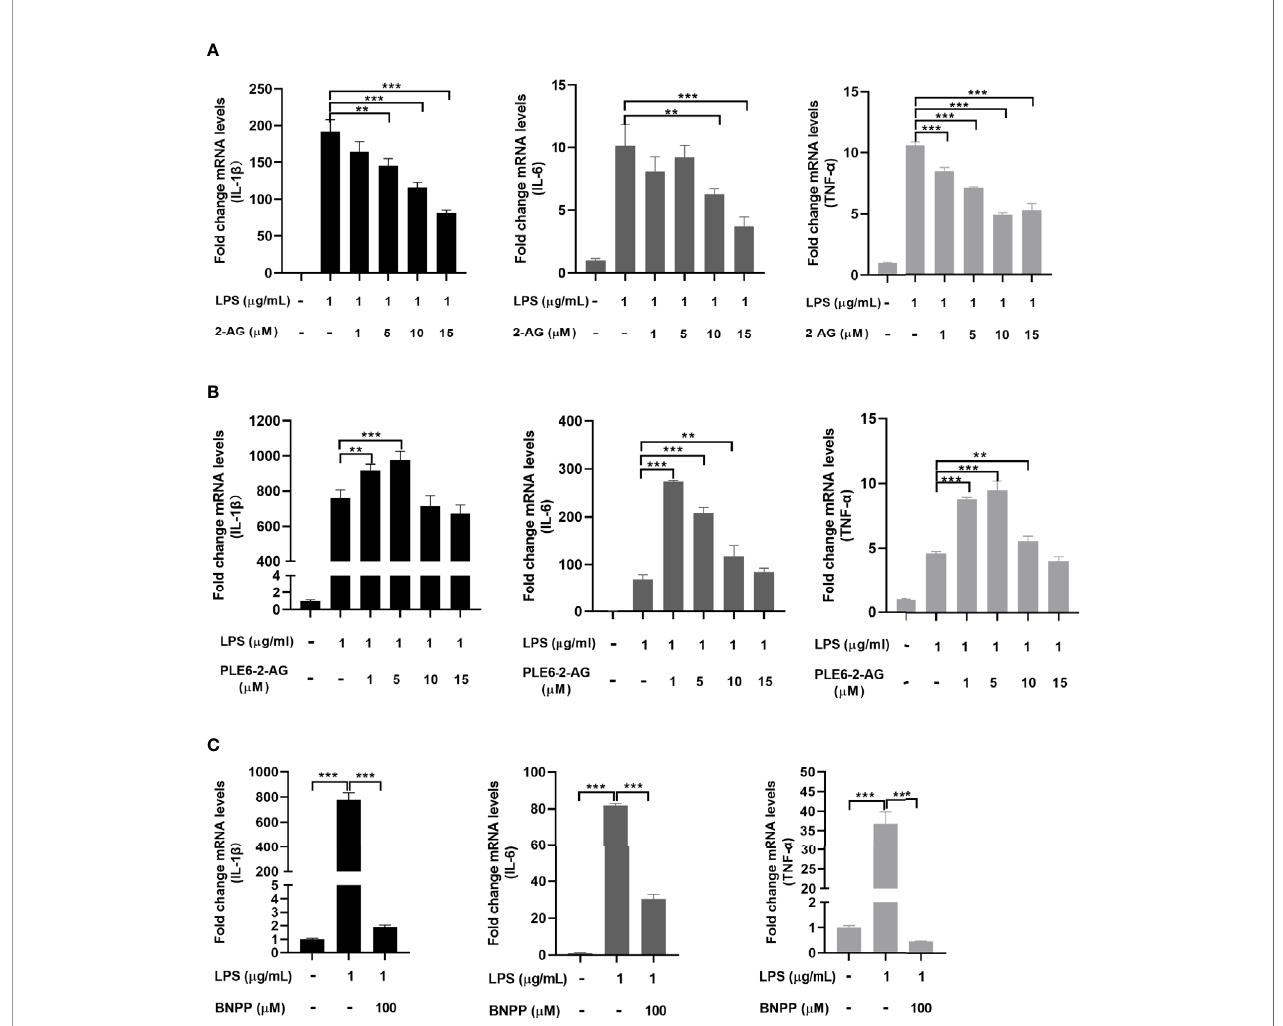
FIGURE 2 | Effect of 2-AG, PLE6-hydrolyzed 2-AG and BNPP on the LPS-stimulated mRNA expression of proin fl ammatory cytokines in PAMs. (A) Effect of 2-AG on the LPS-stimulated mRNA expression of proin fl ammatory cytokines. PAMs were cultured and incubated with LPS (1 µg/mL) and 2-AG at various concentration (1 µM, 5 µM, 10 µM, 15 µM) for 24 h. Total RNA was isolated and analyzed for the mRNA level of IL-1 b , IL-6 and TNF- a by RT-qPCR. (B) Effect of PLE6 hydrolyzed 2- AG on the LPS-stimulated mRNA expression of proin fl ammatory cytokines. PAMs were cultured and incubated with LPS (1 µg/mL) and a 0.5-h preincubation mixture of PLE6 with 2-AG at various concentration (1 µM, 5 µM, 10 µM, 15 µM) for 24 h. Total RNA was isolated and analyzed for the mRNA level of IL-1 b , IL-6 and TNF- a by RT-qPCR. (C) Effect of BNPP on the LPS-stimulated mRNA expression of proin fl ammatory cytokines. PAMs were cultured and preincubated with BNPP (100 µM) for 3 h, and then LPS (1 µg/mL) was treated for another 24 h. The levels of in fl ammatory factors in the cell lysates were detected. Statistical signi fi cance was indicated by asterisks (**P < 0.01; ***P <